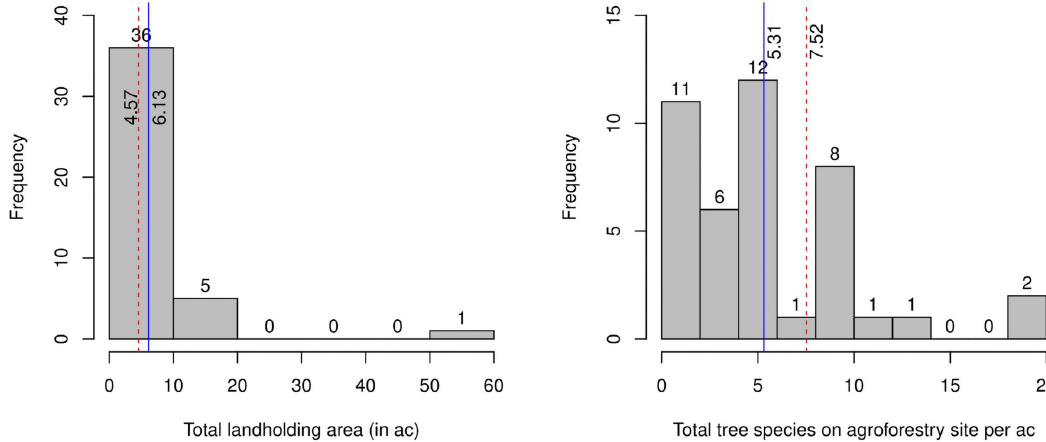
Fig 2. Histograms of total landholding area and tree species’ density. The dashed vertical lines in red represent the mean value of farmer leaders and the solid vertical lines in blue represent the mean value of general members.